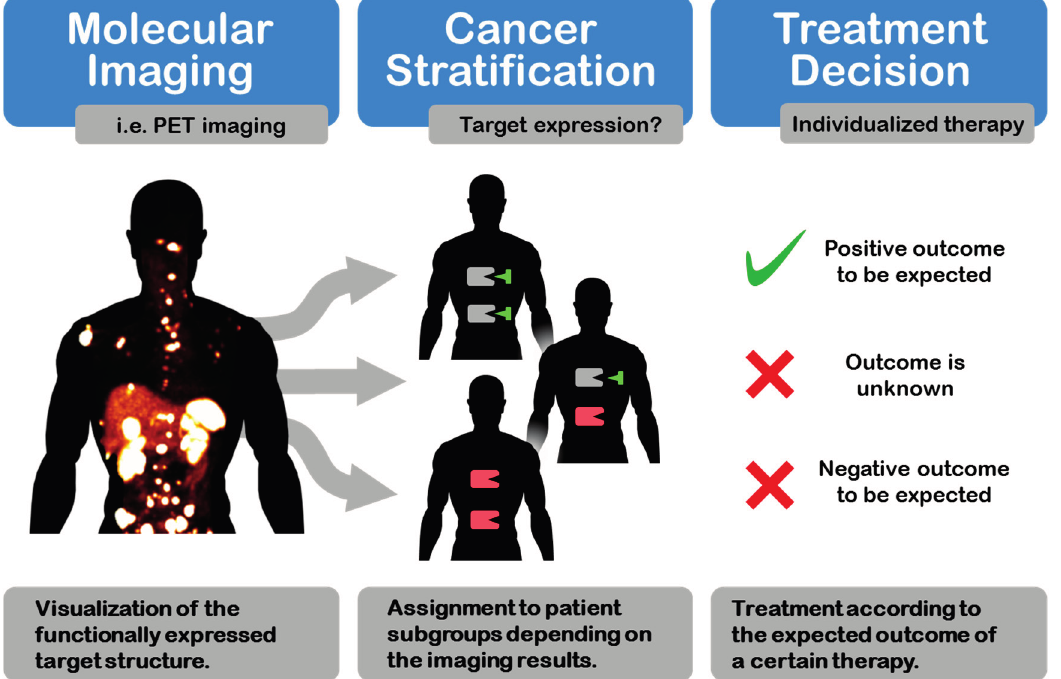
Figure 1. Cancer stratification by molecular imaging allows patients clustering according to the expected outcome of a therapeutic approach by visualizing an expressed biomarker. The resulting patient subgroups can subsequently be treated with the most promising therapy